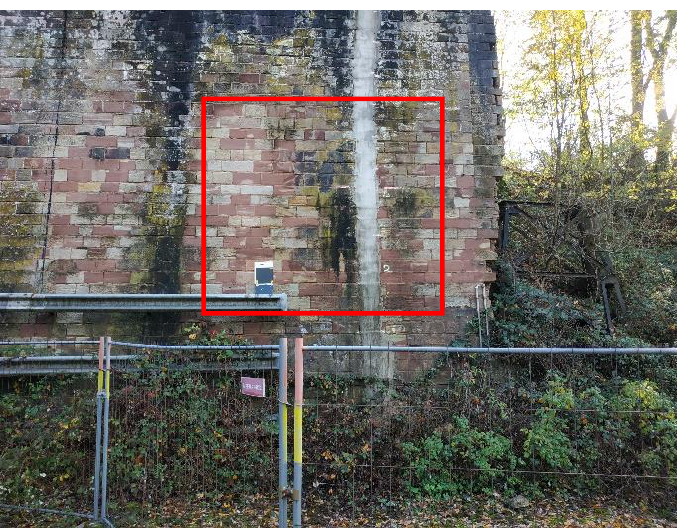
Figure 5. Overview of the wall structure under test. The rectangle shows the approximate view of the LWIR camera.